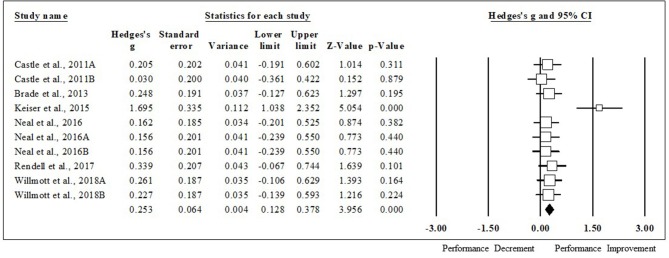
Peak power forest plot. Data are presented as Hedge's g and 95% confidence intervals.